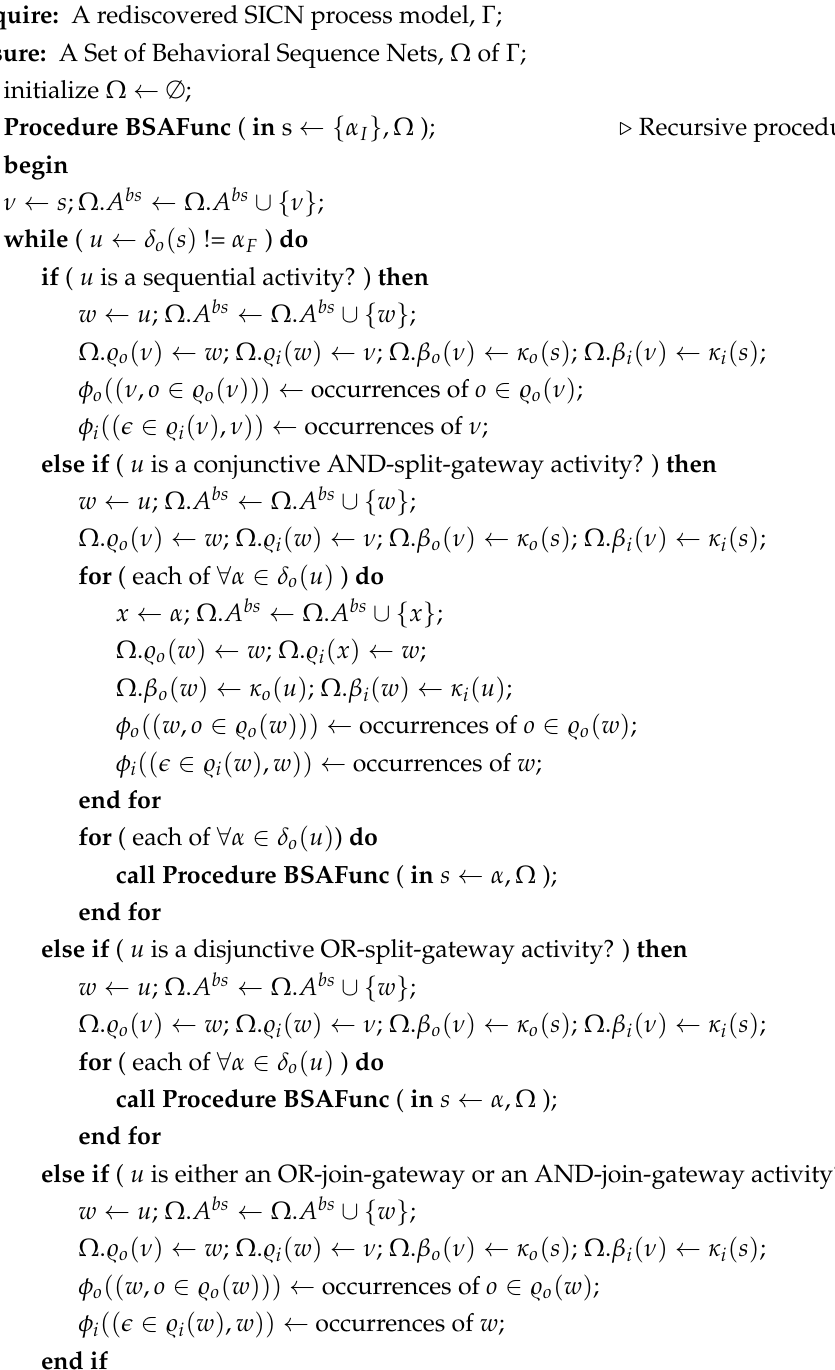
Algorithm 2 The behavioral sequence analysis